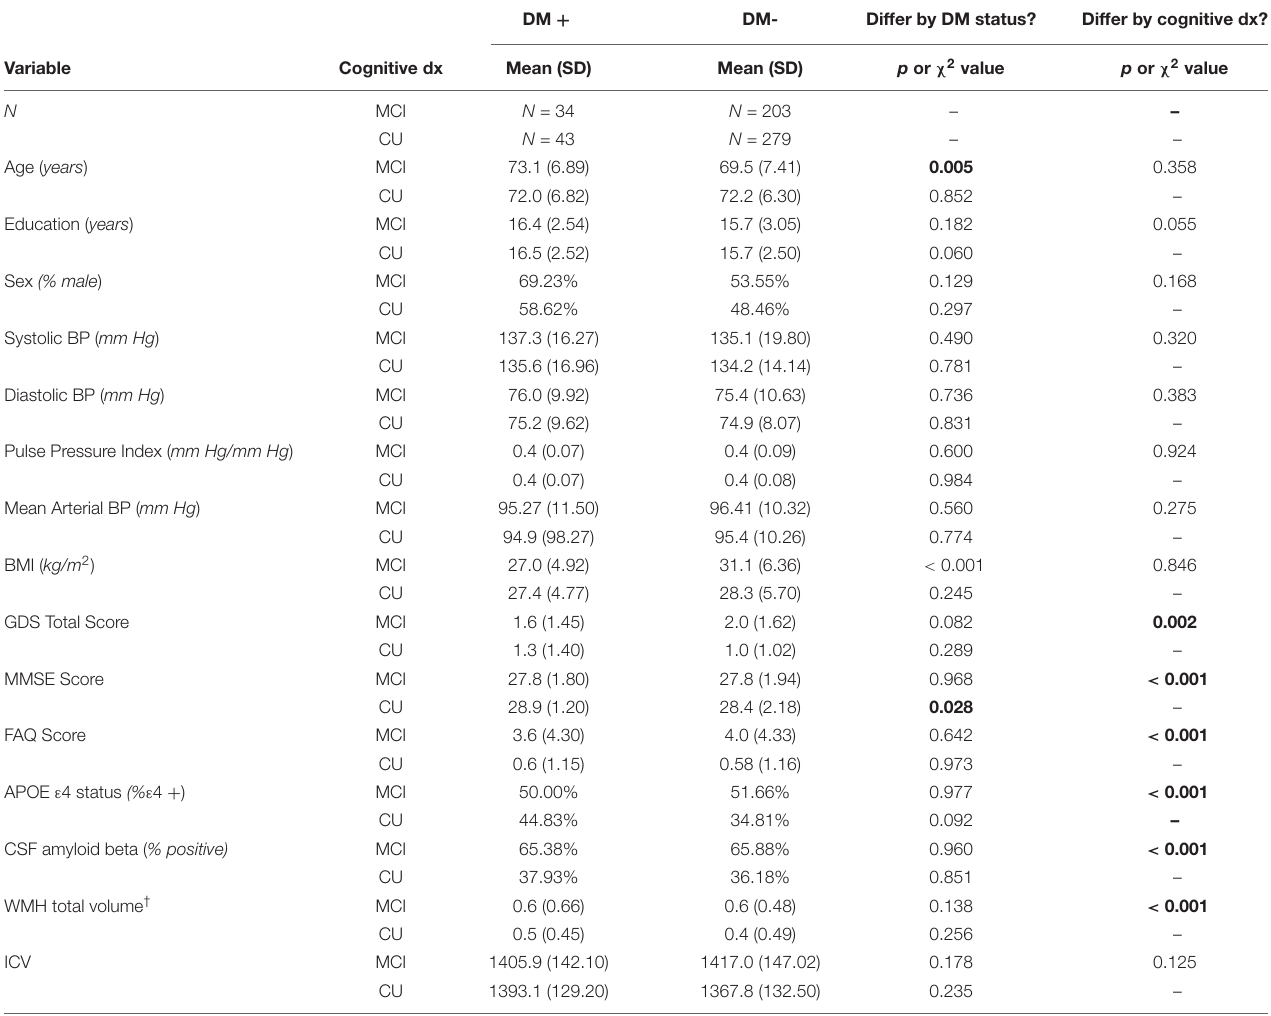
TABLE 1 | Sample characteristics by diabetes status and cognitive diagnosis. DM + DM- Differ by DM